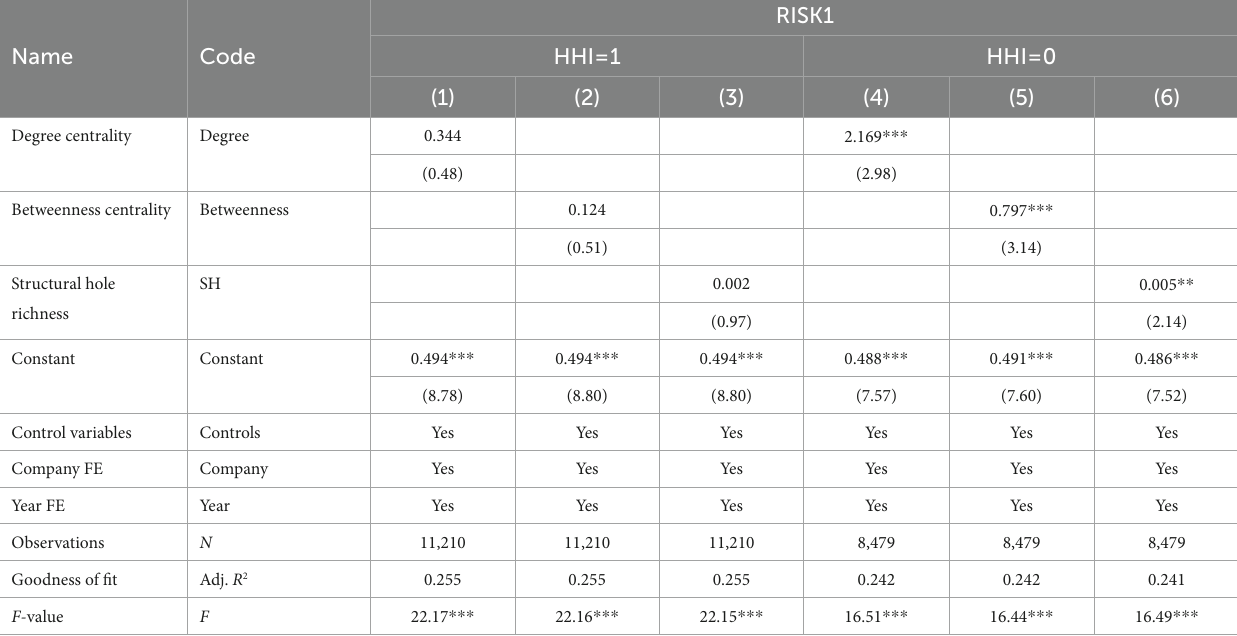
TABLE 12 Further analysis of the intensity of industry competition.